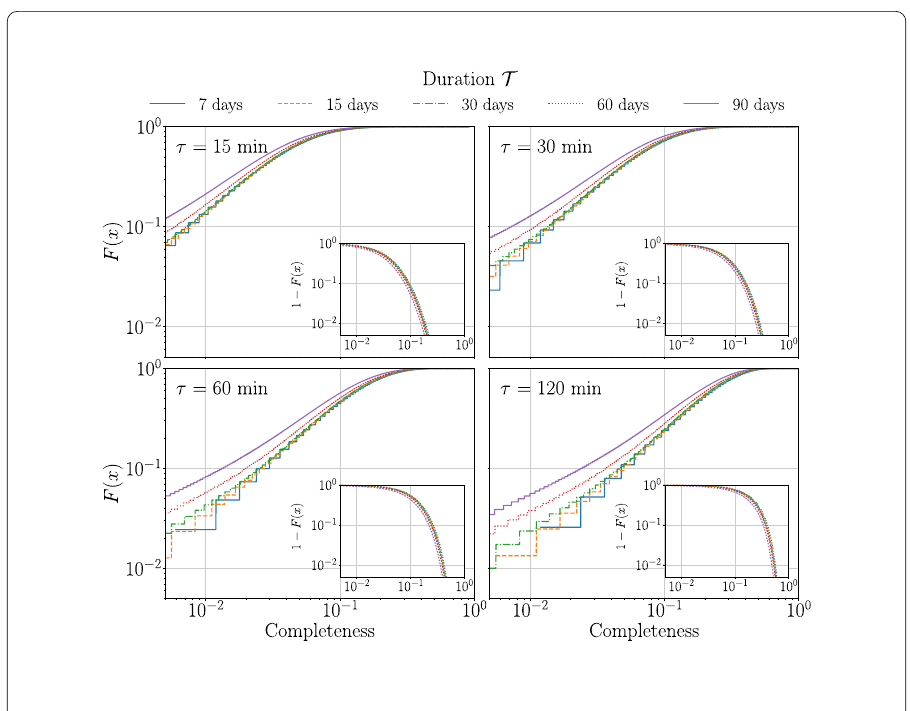
Figure 1 CDF of completeness. Cumulative distributions of the completeness of trajectories over 1.8 million users for different combinations of the observing duration T and the temporal resolution